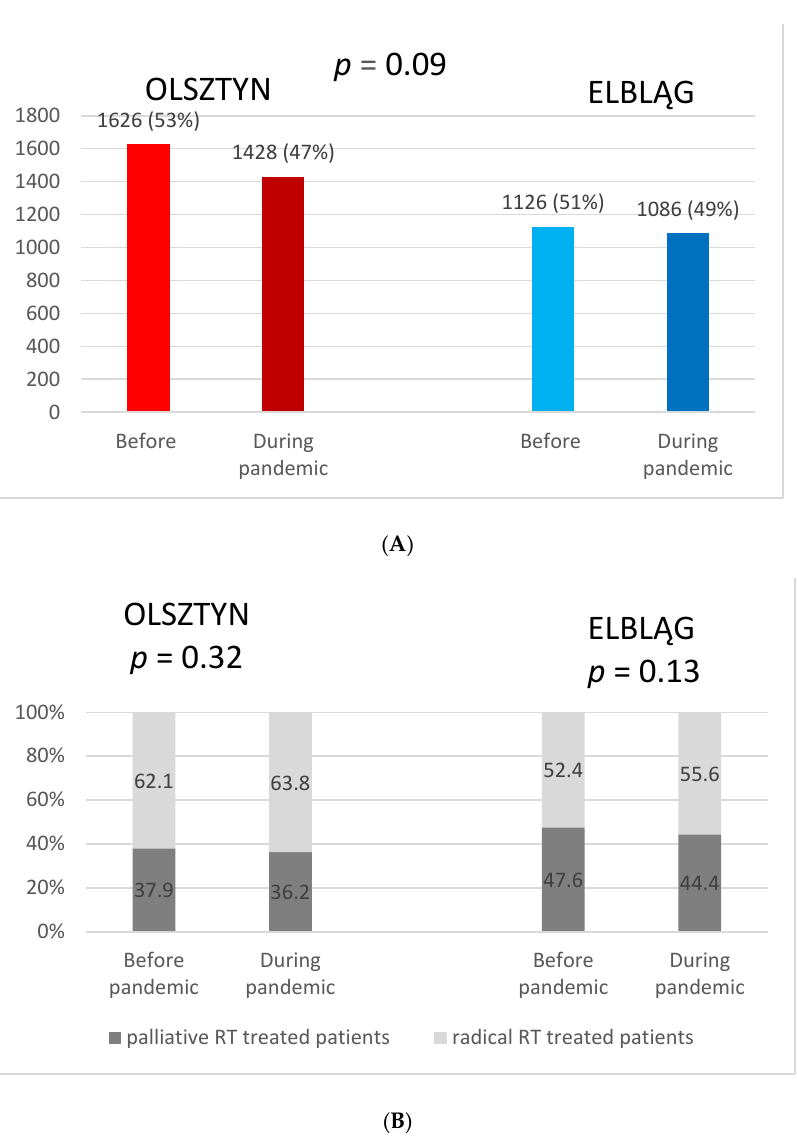
Figure 2. Comparison of patients treated with radiotherapy before and during the pandemic between Olsztyn and Elbląg ( A ). Comparison of percentage of patients treated with radical and palliative radiotherapy in Olsztyn and Elbląg ( B ).